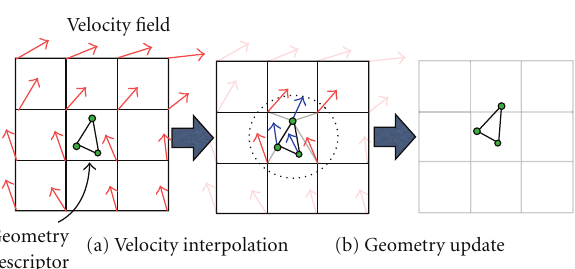
Figure 8: Geometries are updated through the interpolation from the velocity field. This step maintains the consistency between probabilistic and geometrical compartments of the mixture model.